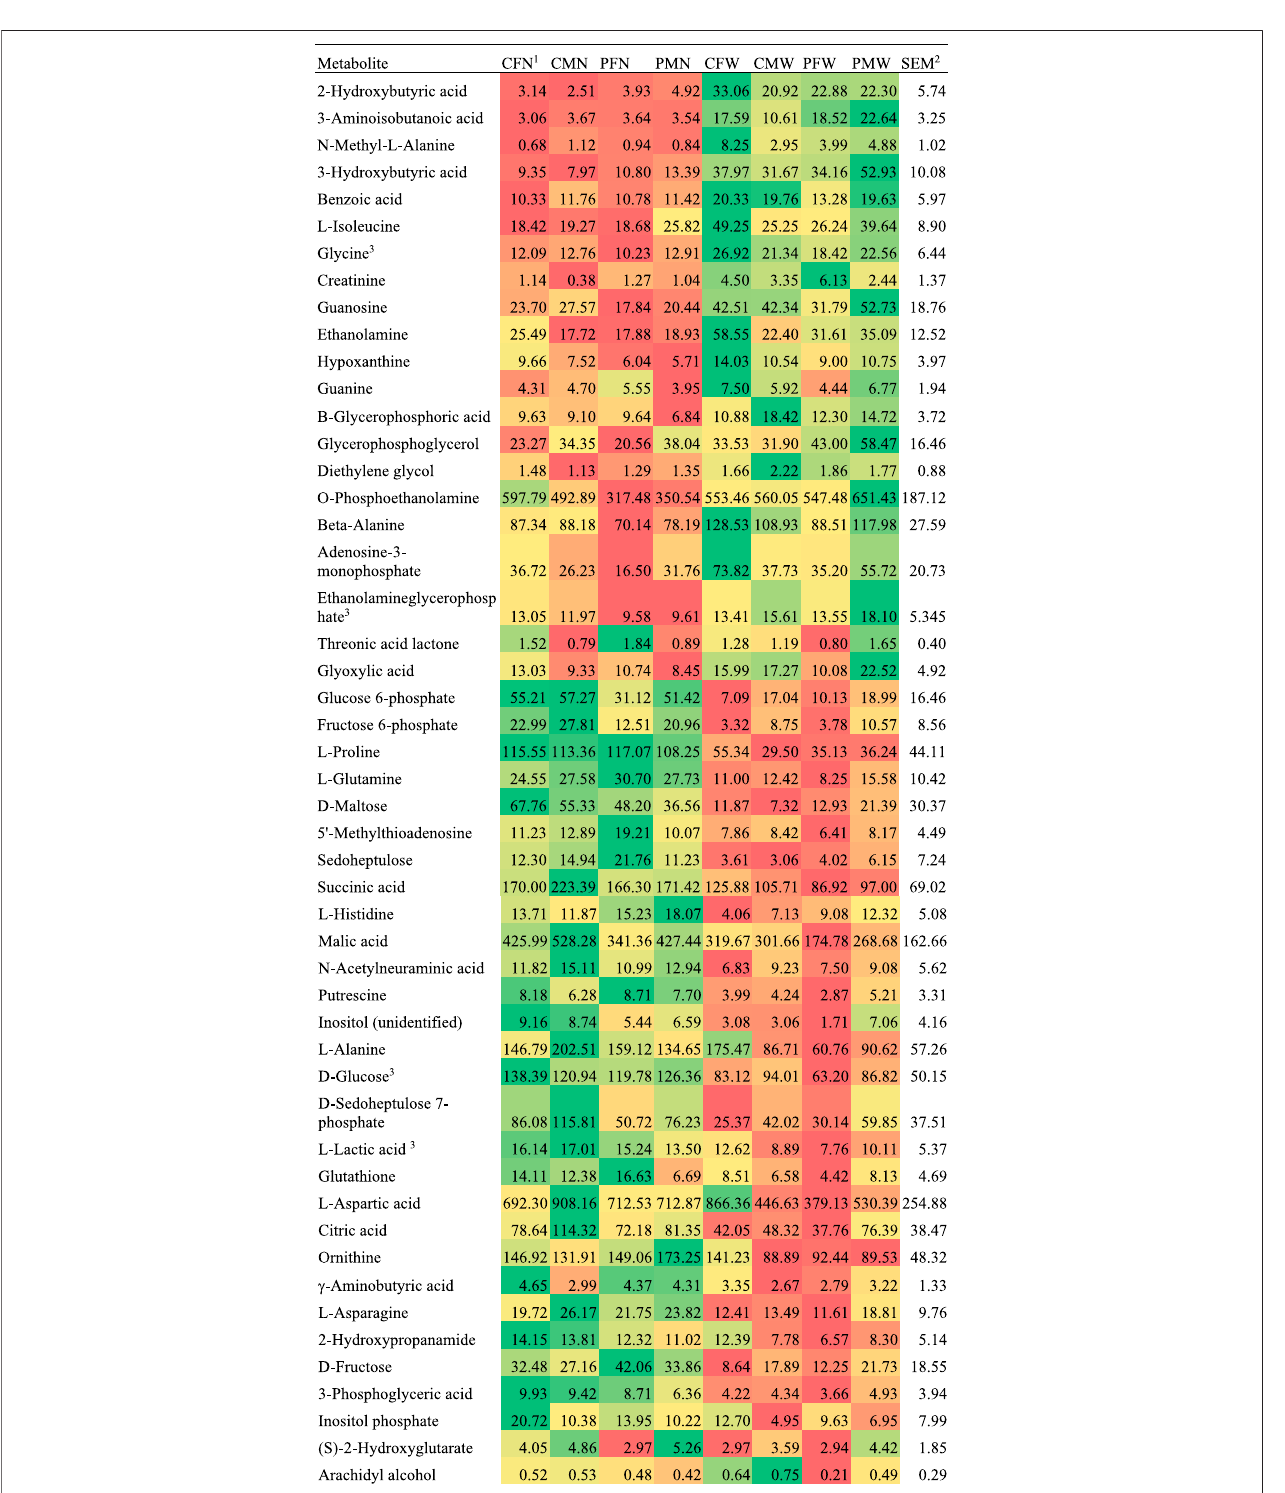
FIGURE1| Abundancepro fi leacrossweaning,maternalimmuneactivation,andsexgroupsformetabolitesthatpresentedweaningeffectaloneorinteractingwith other factors.